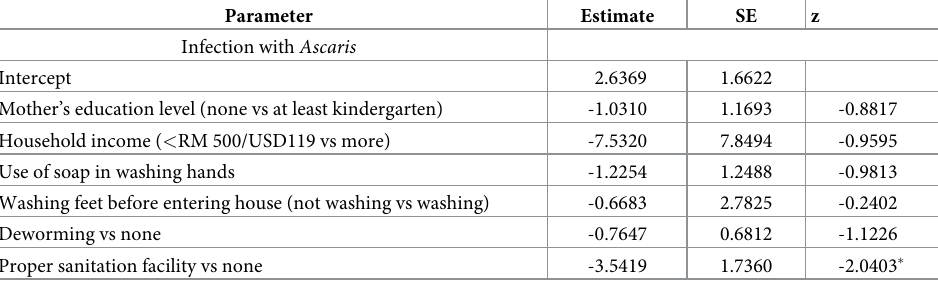
Table 9. Analysis of factors of ascariasis using generalized linear model with families considered as clusters of geohelminthiasis. Bootstrapping with 5000 replicates was performed.